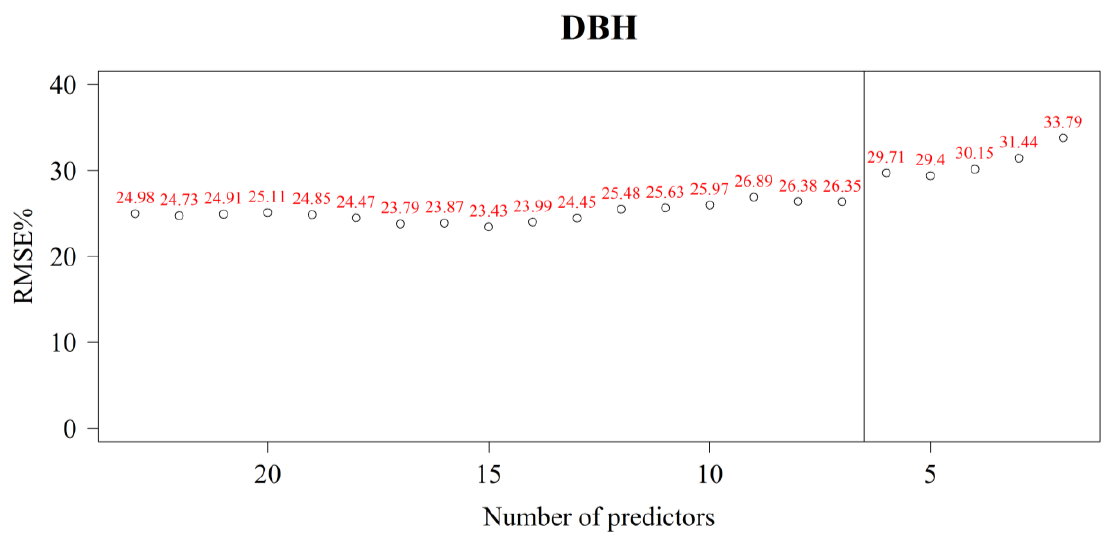
Figure 3. Effect of number of predictors to DBH estimation accuracy in and selection of ALS features for the forested southern part of the study area.